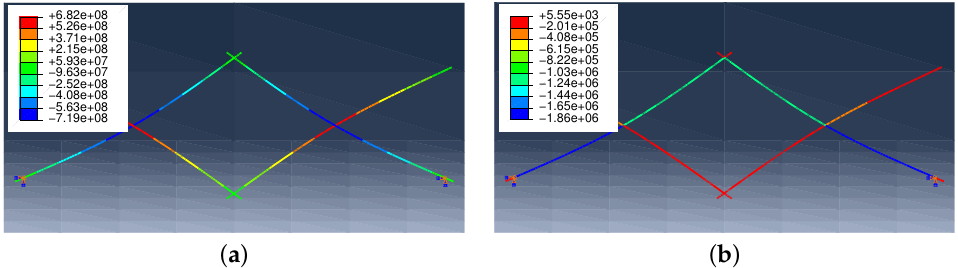
Figure 7. Distribution of sectional forces (Response magnification 100 times): ( a ) bending moment distribution; ( b ) axial force